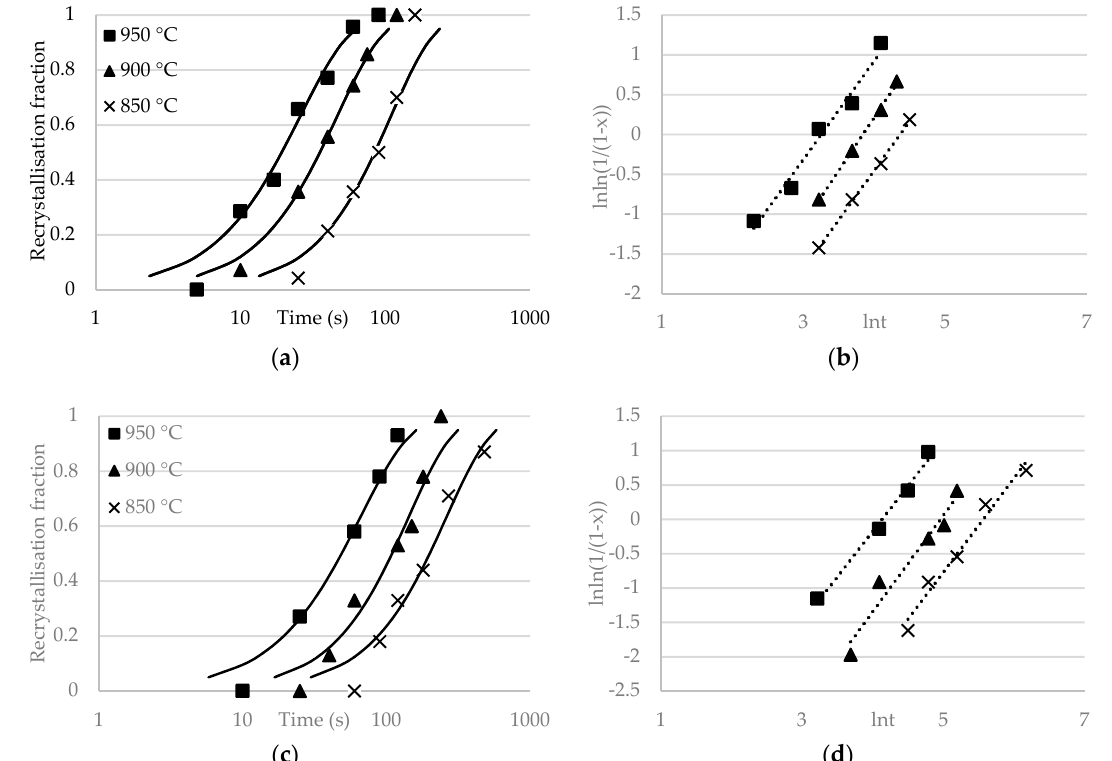
Figure 4. Recrystallisation kinetics and double log diagram for 160 µm mode grain size samples deformed to ( a , b ) 0.3 strain and ( c , d ) 0.2 strain at room temperature, then annealed at three temperatures (850, 900 and 950 °C).